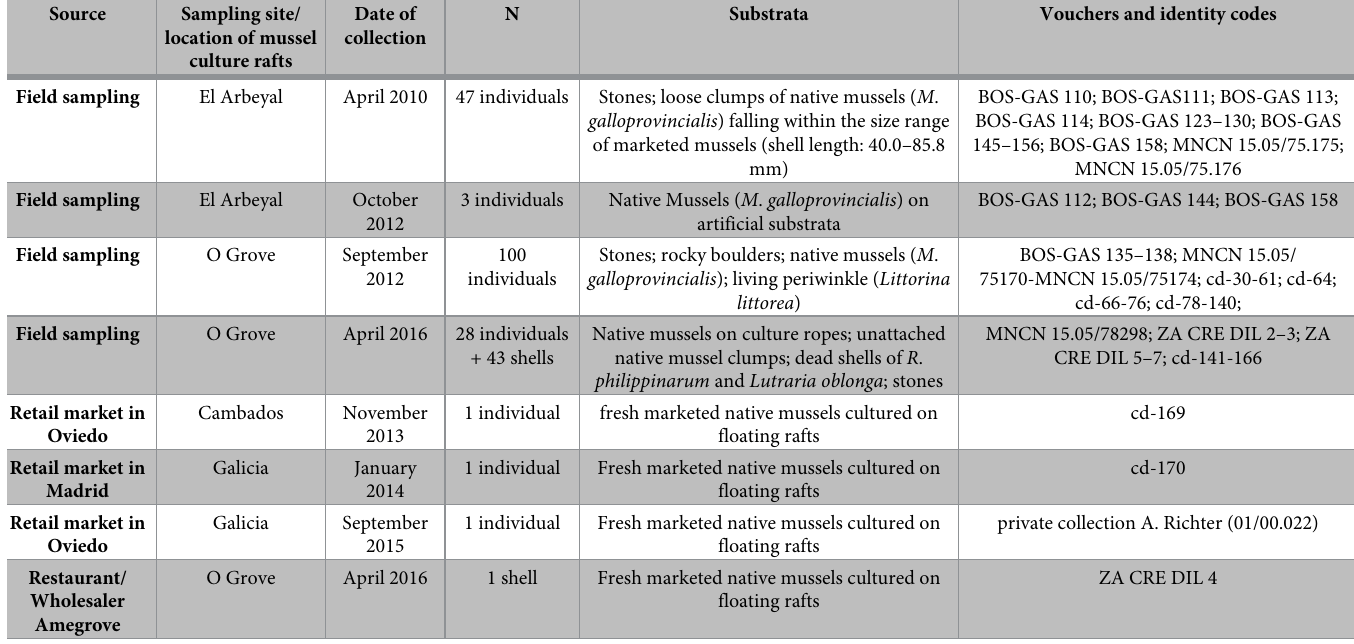
Table 1. Crepitapella dilatata samples used in the present